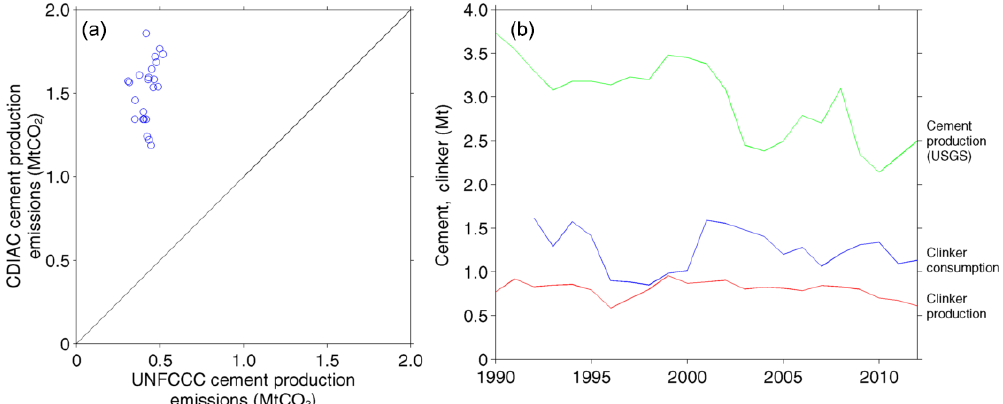
Figure A3. Netherlands. (a) CDIAC vs. UNFCCC. (b) Clinker, cement. Note “clinker consumption” is production plus imports less exports but excludes stock changes (sources: van Oss, 1994–2019; Boden et al., 2013; UNFCCC, 2014; UNSD,